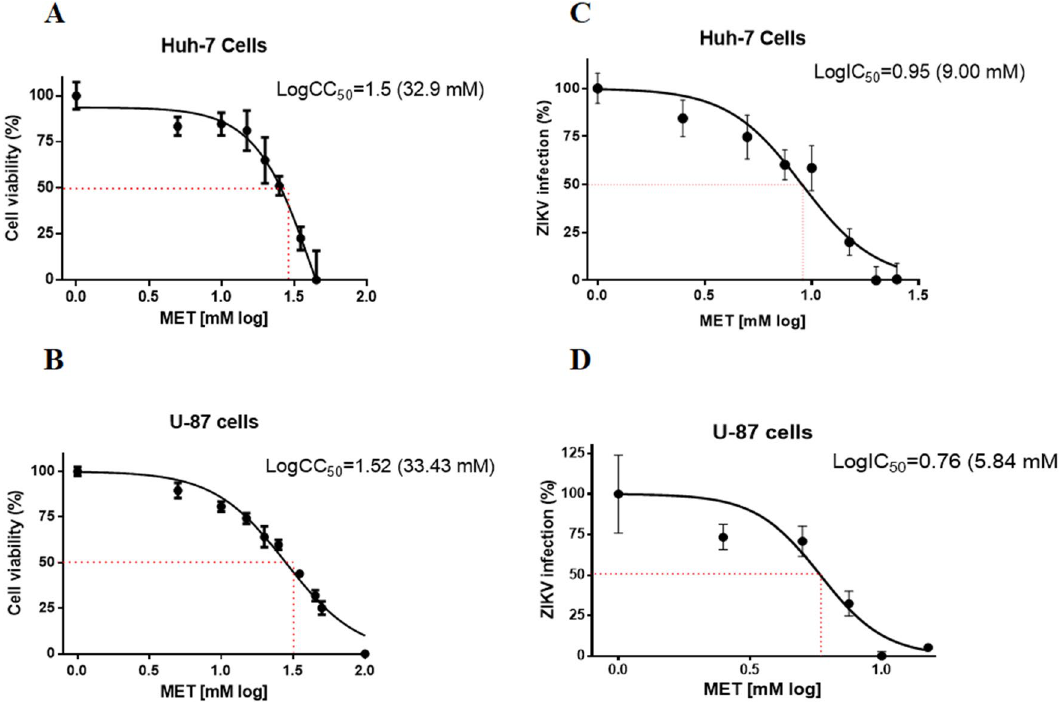
Figure 1. Cytotoxicity (CC 50 ), inhibition concentration (IC 50 ), and selectivity index (SI) of MET in Huh-7 and U-87 cell lines infected with ZIKV. The CC 50 on Huh-7 ( A ) and U-87 ( B ) cells were calculated with the vehicle (H 2 O) or increasing concentrations of MET (1, 2.5, 5, 7.5, 10, 15, 20, and 25 mM). The cell viability was evaluated by MTT assay at 24 h, and a linear regression analysis estimated the CC 50 . The IC 50 was calculated for MET in ZIKV-infected Huh-7 ( C ) and U-87 ( D ) cells. Both cell lines were treated with MET (1, 2.5, 5, 7.5, 10, 15, 20, and 25 mM) or vehicle (H2O) for 24 h. The reduction of infection by MET was evaluated by